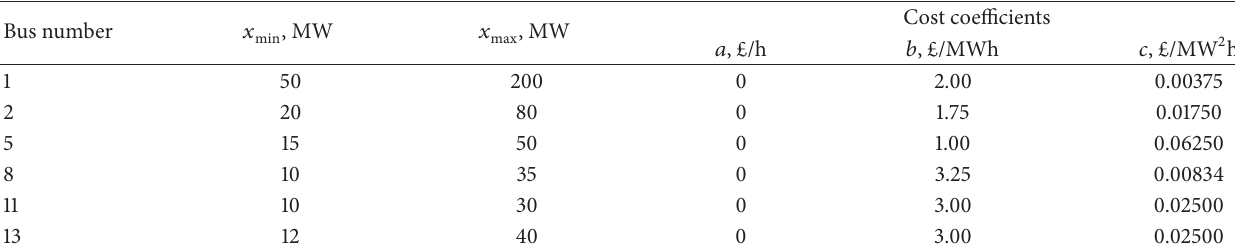
Table 1: Generator data.